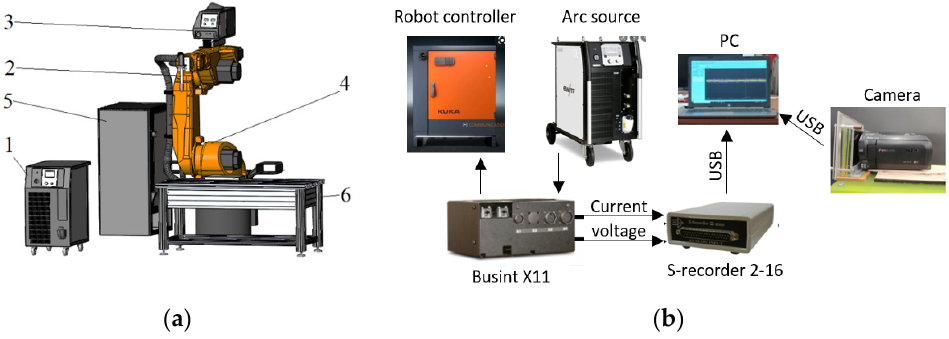
Figure 1. The WAAM station, ( a )—appearance with components, ( b )—connection diagram 1—arc source, 2—arc torch, 3—the wire feeder, 4—robot, 5—robot controller, 6—welding table. OK Autrod 12.51 (Elektriska Svetsnings-Aktiebolaget (ESAB), Göteborg, Sweden) wire with a diameter of 1.2 mm was used as a filler and steel 1020 was used as a substrate (Table 1). Pure CO 2 was used as a shielding gas. Table 1. Substrate and wire (OK Autrod 12.51) chemical composition.